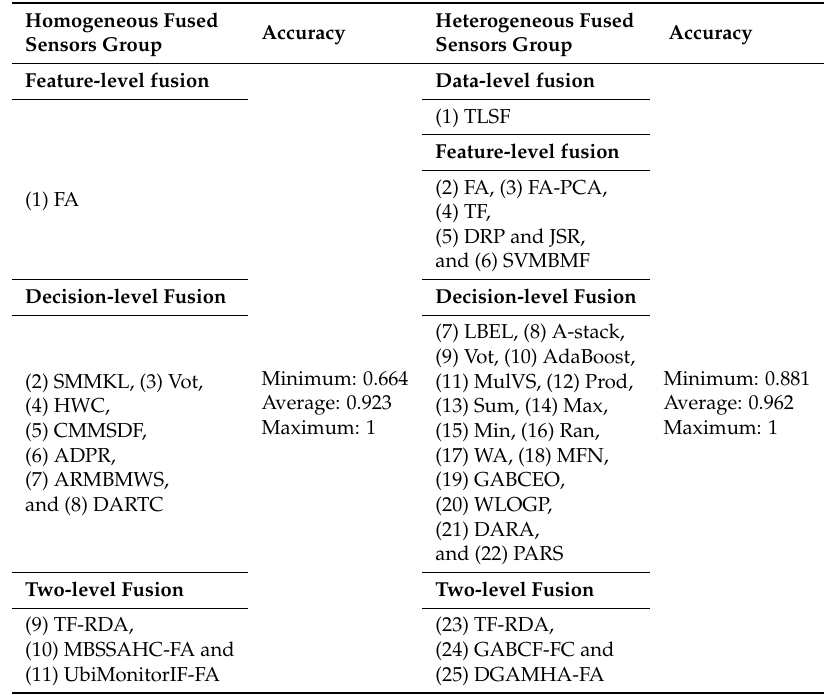
Table 6. The minimum, average and maximum accuracy reached by the “Homogeneous fused sensors” group and by the “Heterogeneous fused sensors”